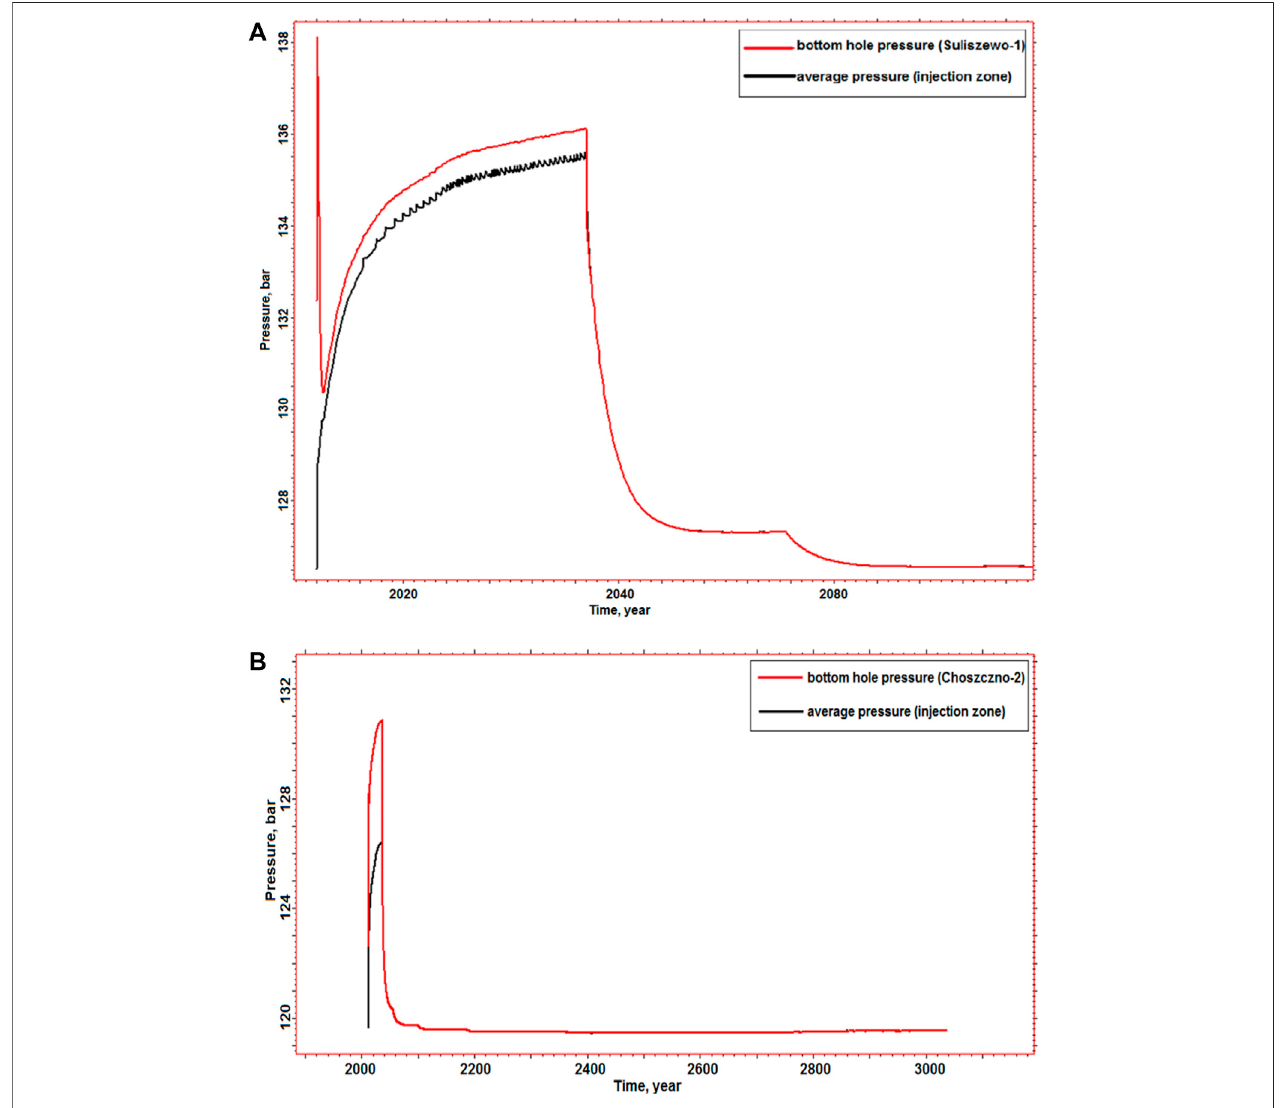
FIGURE 6 | Bottom pressure in the (A) Suliszewo-1 and (B) Choszczno-2 wells, respectively and average formation pressure in the injection zone during and after injection.